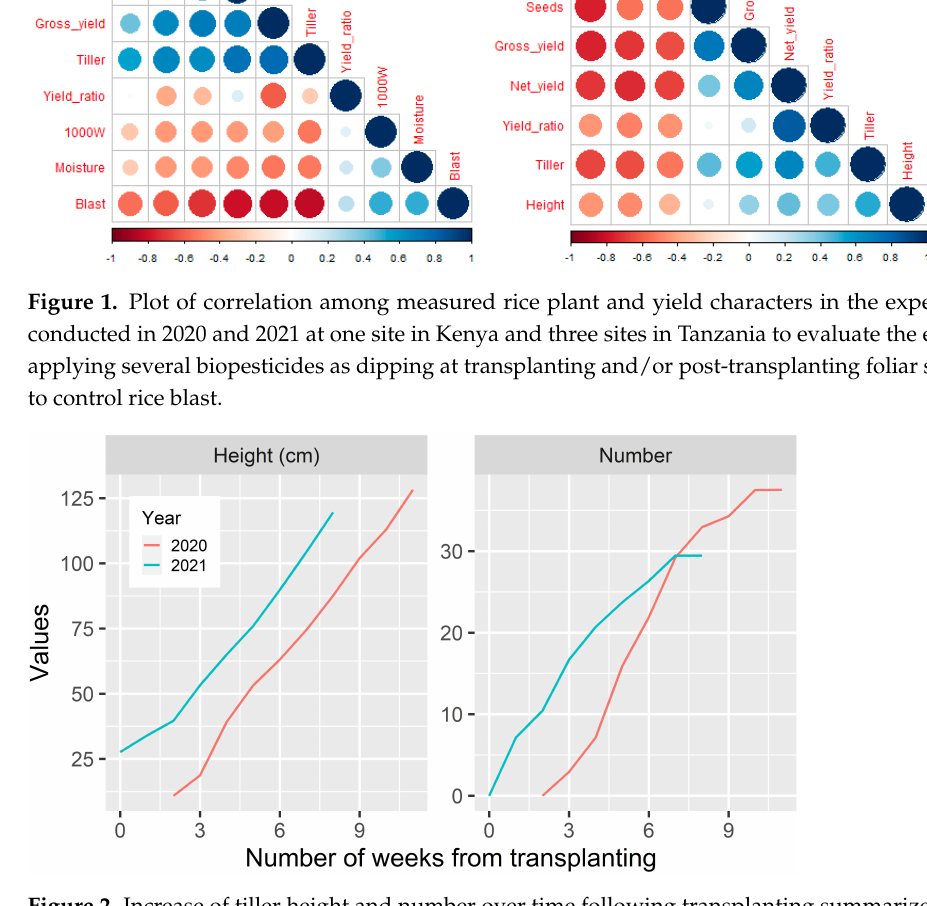
Figure 2. Increase of tiller height and number over time following transplanting summarized across all 14 treatments in 2020 and 2021; 12 of the 14 treatments are four biopesticides applied as a dipping Figure 1. Plot of correlation among measured rice plant and yield characters in the experiments treatment at transplanting, weekly post-transplanting foliar sprays, and both at one site in Kenya. conducted in 2020 and 2021 at one site in Kenya and three sites in Tanzania to evaluate the effects Two controls (water as negative, and fungicide as positive) were included for of applying several biopesticides as dipping at transplanting and/or post-transplanting foliar spray- ing to control rice blast.